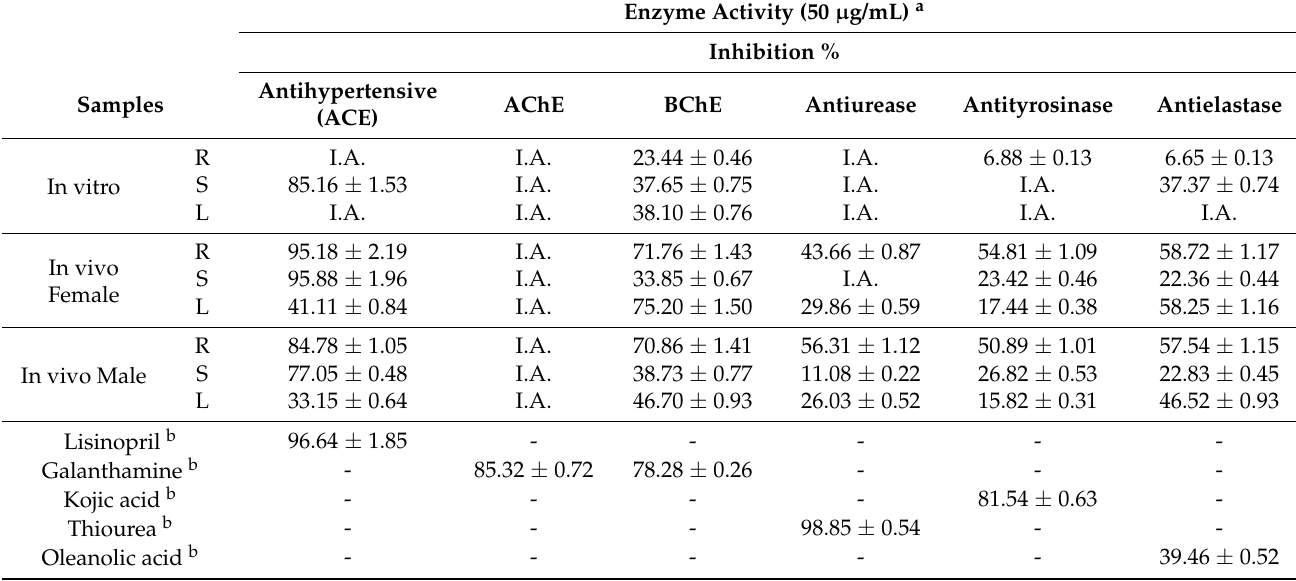
Table 2. Antihypertensive, anticholinesterase, antiurease, antityrosinase and antielastase enzyme inhibition activities resulted from prepared ethanol extracts of Pistacia khinjuk Stocks in vivo and in vitro samples. a : Values are given as the mean and standard deviation of three parallel measurements (200 µ g/mL). I.A.: Inactive, b : Standard